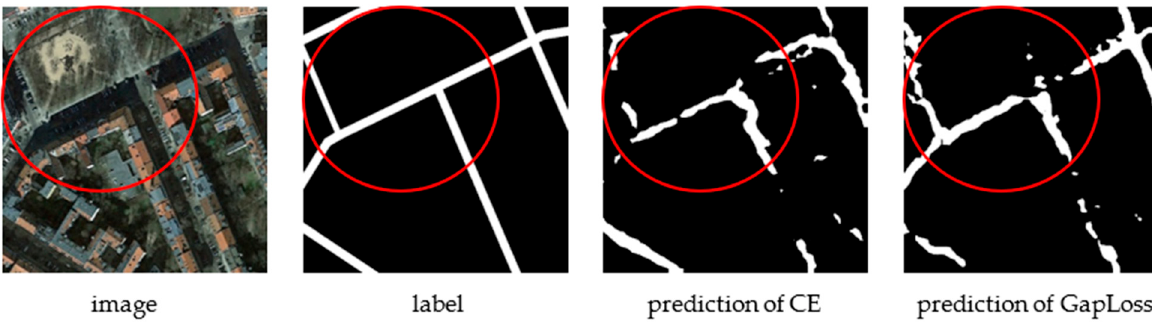
Figure 12. Unet++ results with CE and GapLoss on Aerial Image Segmentation Dataset Figure 13. MUNet results with CE and GapLoss on Aerial Image Segmentation Dataset 3.6. Comparison of Different K There was a hyperparameter K found when using GapLoss. In order to verify the influence of its value on the results and to find the optimal value of K , we used the PSPNet network model as an example, which was considered the best network and is well-known, and we conducted experiments on the Massachusetts Roads Dataset from K = 0 to K = 100 at intervals of 10. The results are shown in Table 4. Table 4. The results of PSPNet with different K values on Massachusetts Roads Dataset. K